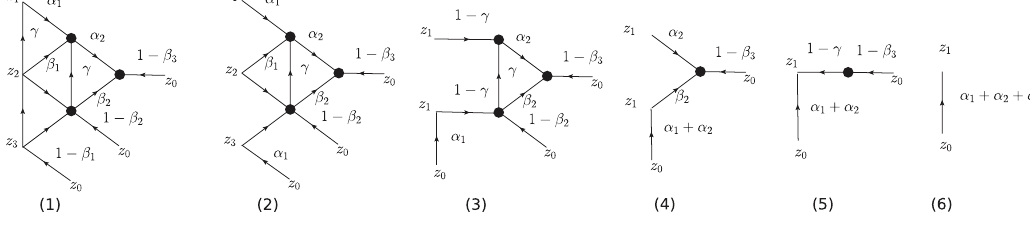
Figure 8 . Amputation of propagators from the eigenfunction (cid:9)( x 1 ; x 2 ; x 3 z 1 ; z 2 ; z 3 ) and then j reduction in the limit z k z 1 to the simple power [ z 0 z 1 ] (cid:0) (cid:11) 1 (cid:0) (cid:11) 2 (cid:0) (cid:11) 3 . We perform amputation of ! (cid:0) [ z 1 z 2 ] and [ z 2 z 3 ] lines in (1), then (2) we reduce the (cid:12)rst row z 2 ; z 3 z 1 leading to (3). We can (cid:0) (cid:0) ! open the triangle in (3) to a star, so that integrations in upper-left, and then lower-left vertex are performed using chain relation and star-triangle relation. At the next step (4) we join propagators with coinciding coordinates on the left, and performing the last integration (5) via chain relation, the eigenfunction is reduced to a simple line (6).